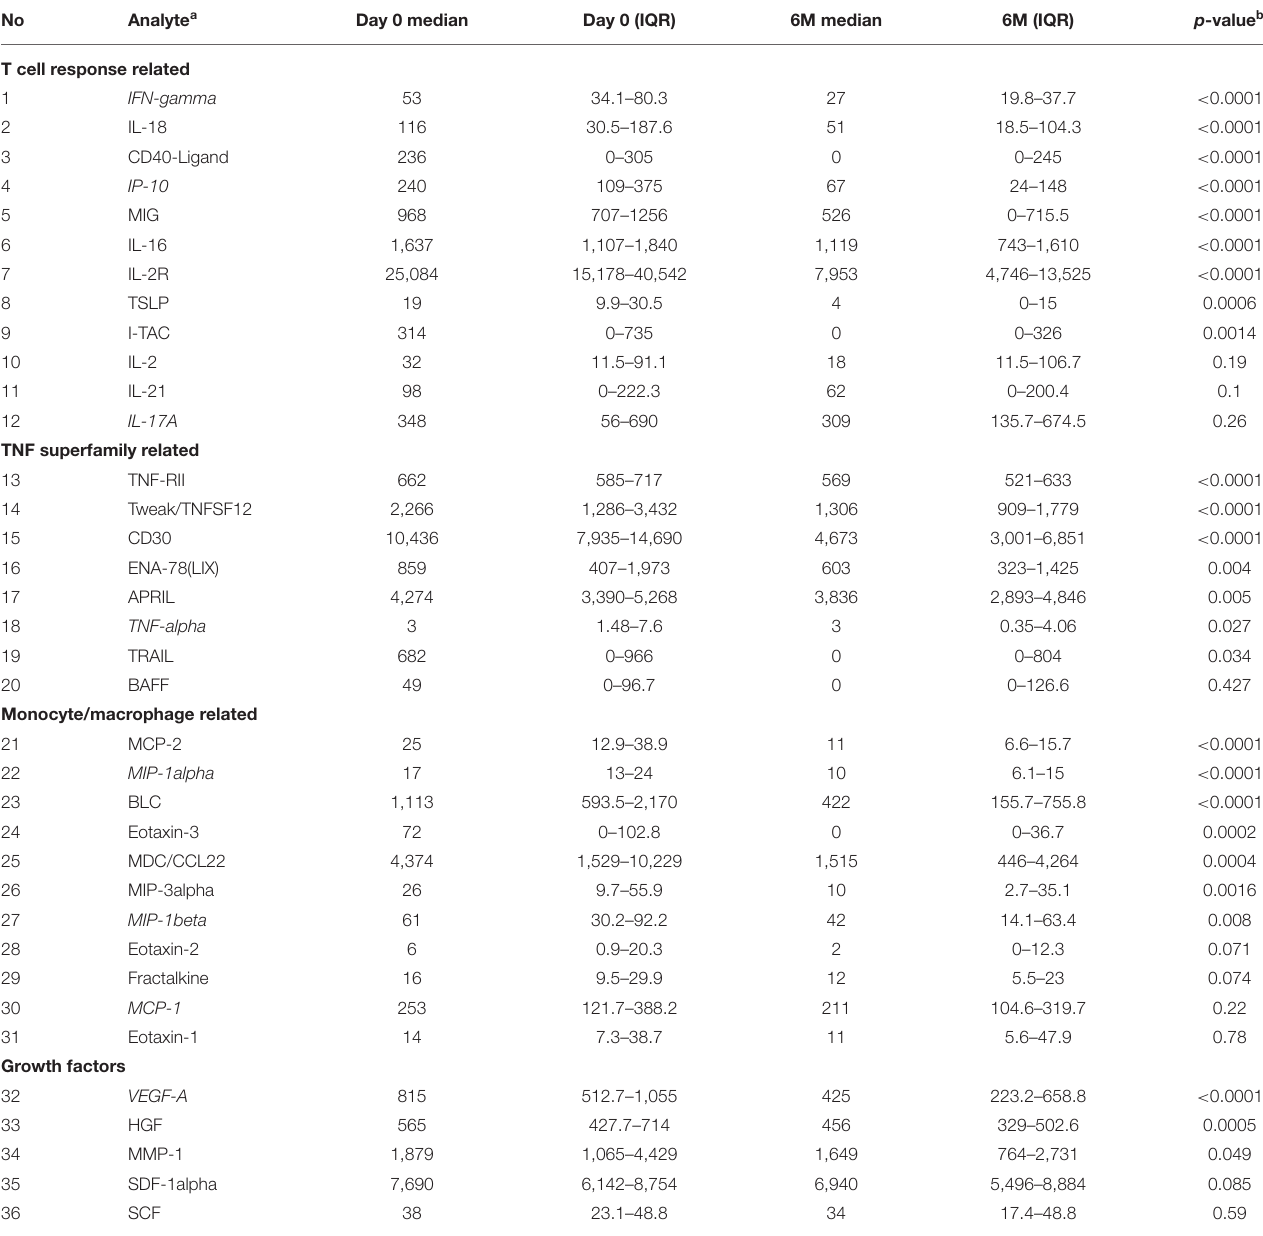
TABLE 1 | Multiplex analysis of